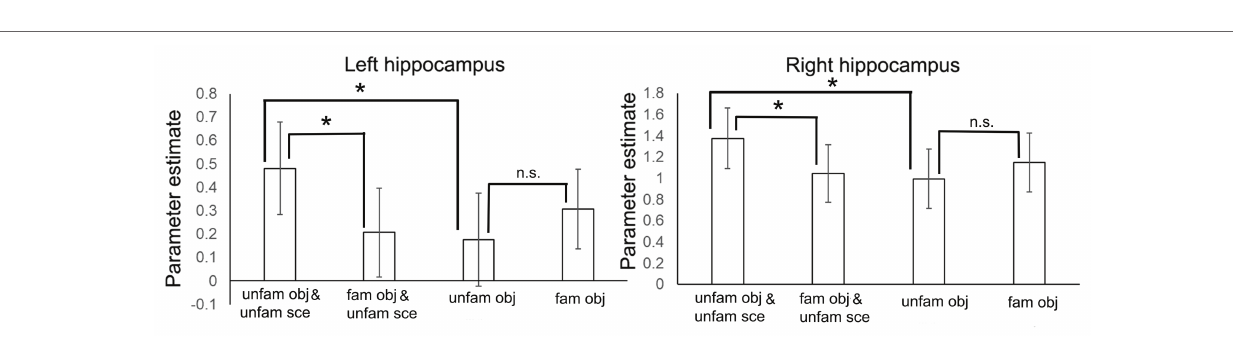
FIGURE 4 | Parameter estimates (±1 SE) from the interaction analysis shown separately for the four conditions and for left and right hippocampus. * p < 0.05.